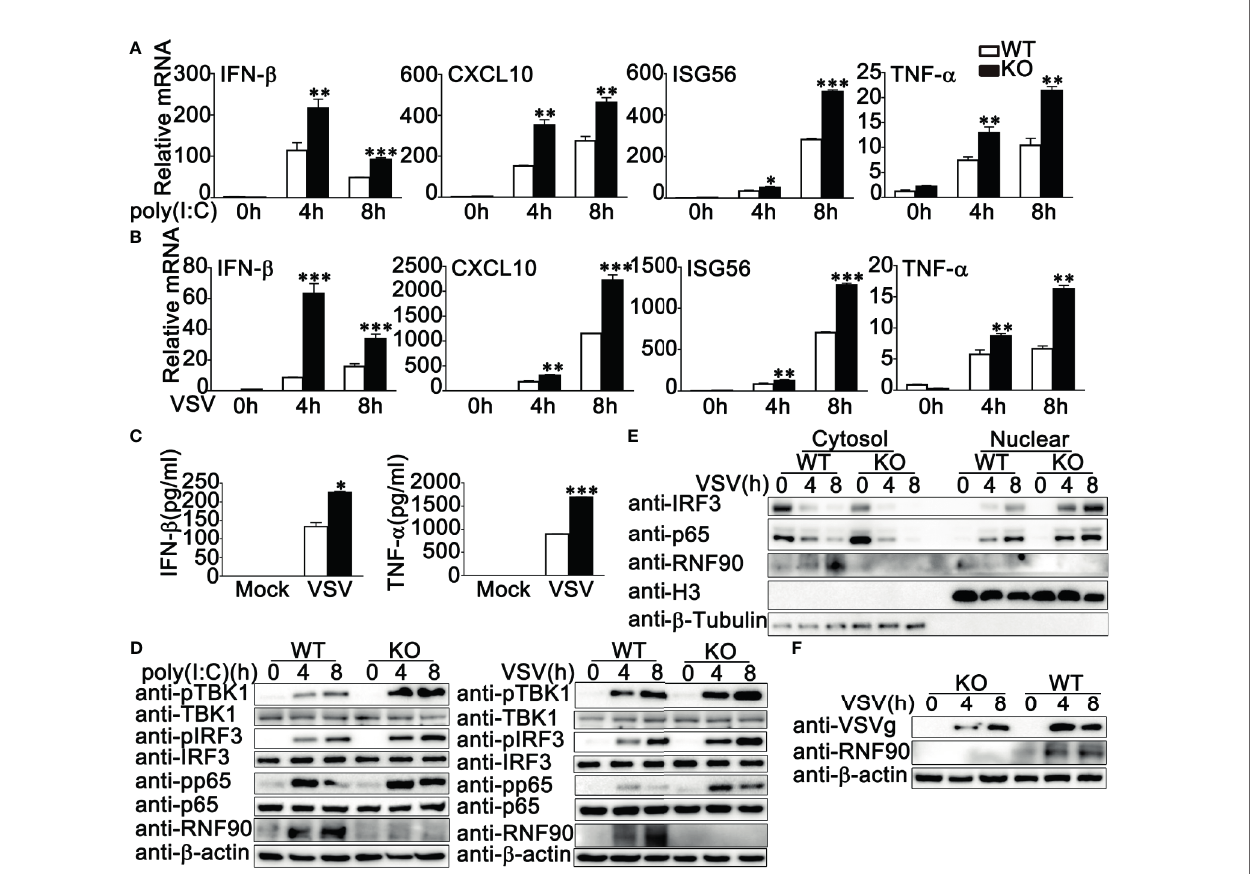
FIGURE 5 | RNF90 de fi ciency promotes RNA virus-triggered innate immune responses in BMDMs. (A, B) WT and RNF90-de fi cient (KO) BMDMs were treated with poly(I:C) (2.5 m g/ml) (A) or VSV (MOI = 1) (B) for indicated time periods. Then the cells were lysed for real-time PCR analysis. (C) WT and RNF90-de fi cient (KO) BMDMs were infected with VSV (MOI = 1) for 24 h. The supernatants were collected and subjected to ELISA analysis. (D) WT and RNF90-de fi cient (KO) BMDMs were treated with poly(I:C) (2.5 m g/ml) or VSV (MOI = 1) for indicated time periods. Then the cells were lysed for immunoblot analysis. (E) WT and RNF90-de fi cient (KO) BMDMs were infected with VSV (MOI = 1) for indicated time points and then fractionated into cytosolic and nuclear subfractions. The immunoblot assay was performed as indicated. (F) WT and RNF90-de fi cient (KO) BMDMs were infected with VSV (MOI = 1) for indicated time points. Then the cells were lysed